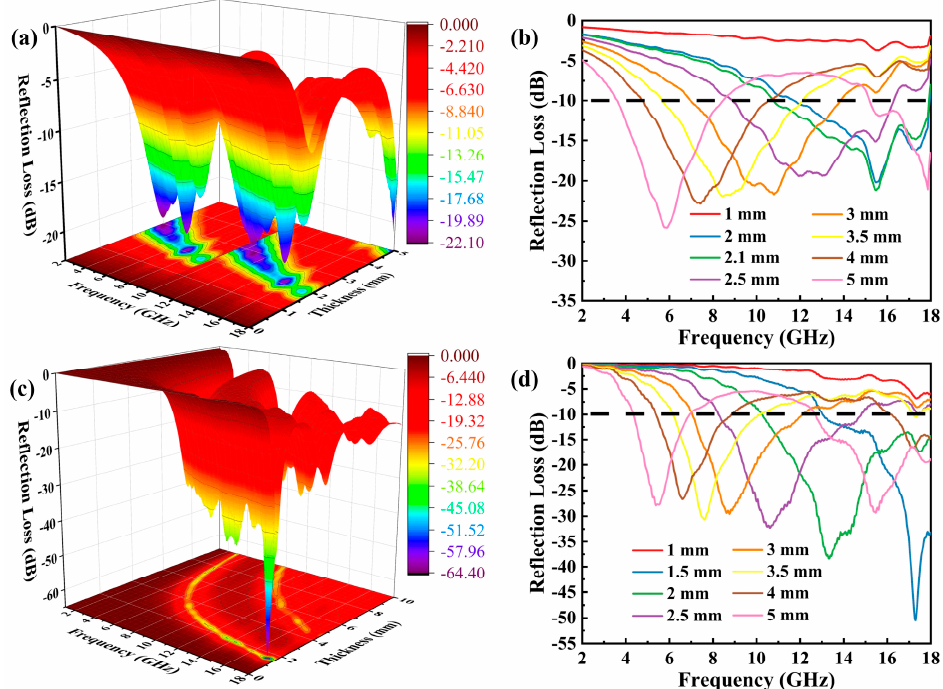
Figure 4. The 3D reflection loss pattern of ( a ) NM; ( c ) C-N@NM; Reflection loss curves of ( b ) NM; ( d ) C-N@NM.